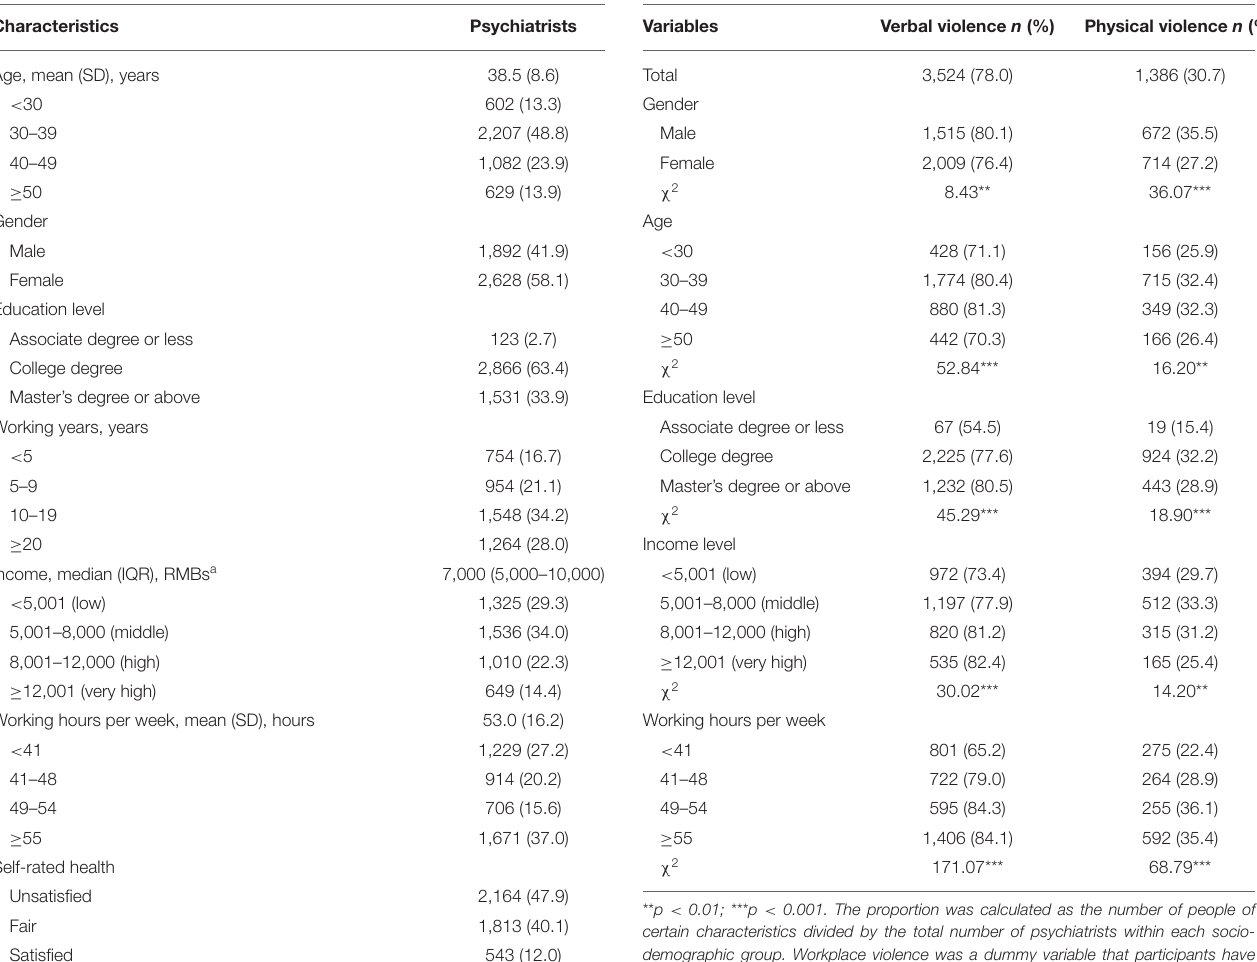
TABLE 1 | Characteristics of the participants ( n = 4,520). TABLE 2 | The prevalence of exposure to workplace violence among